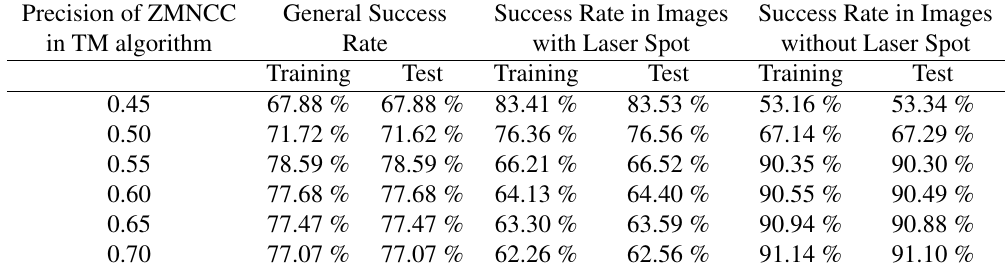
Table 6. Analysis of the influence of the TM precision parame- ter for TM + FRBS expert (i.e., by using initial RB generated by experts in 16 ) when color is still not considered.